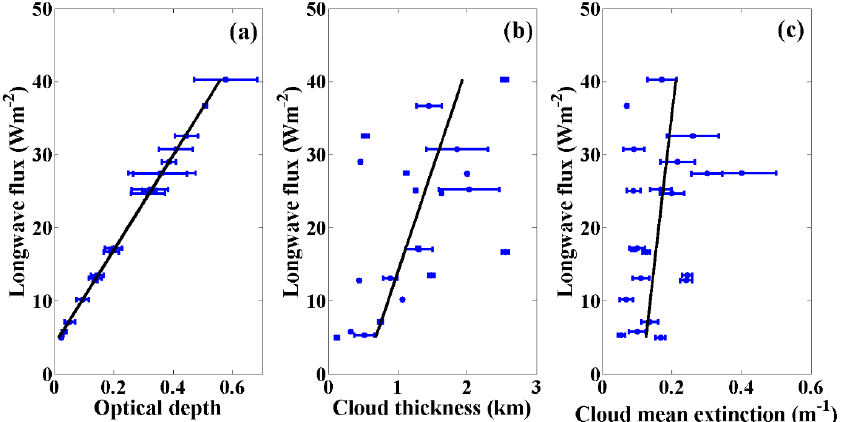
Figure 9. Relationships between optical depth, cloud thickness, extinction coefficient, and longwave